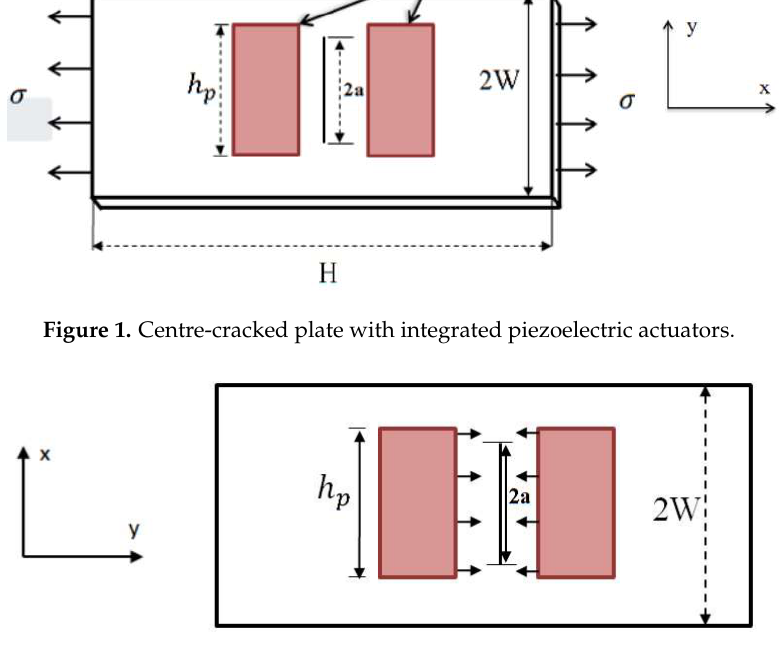
Figure 2. Centre-cracked plate with only piezoelectric actuators active.